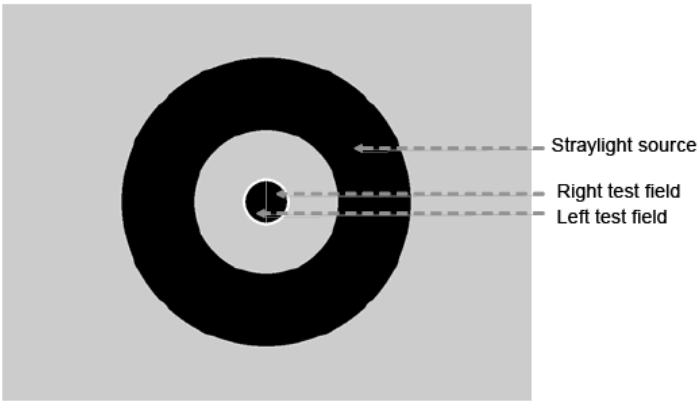
Figure 2. An example of test fields observed inside the C-Quant ocular opening. During the experiment, the outside circle is illuminated to generate the retinal straylight as the participant judging in which the central circle hemifield the light flickers stronger.